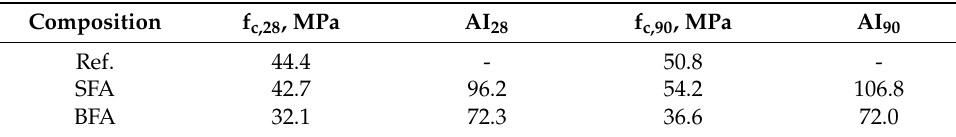
Table 4. Activity index of tested fly